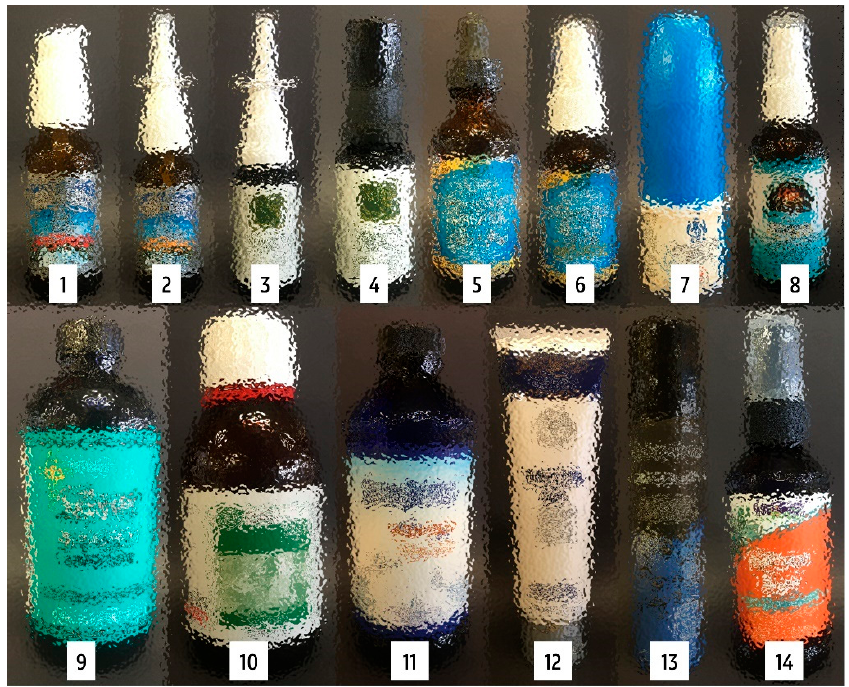
Figure 1. Overview of the 14 different silver products. The label information can be found in Table 1 and Table 2.